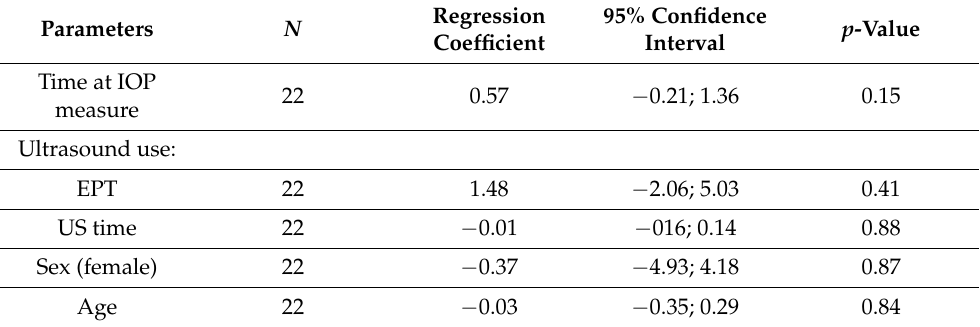
Table 3. Results of the multiple linear regression analysis between the change between preoperative and 6 month intraocular pressure and the studied parameters ( N =